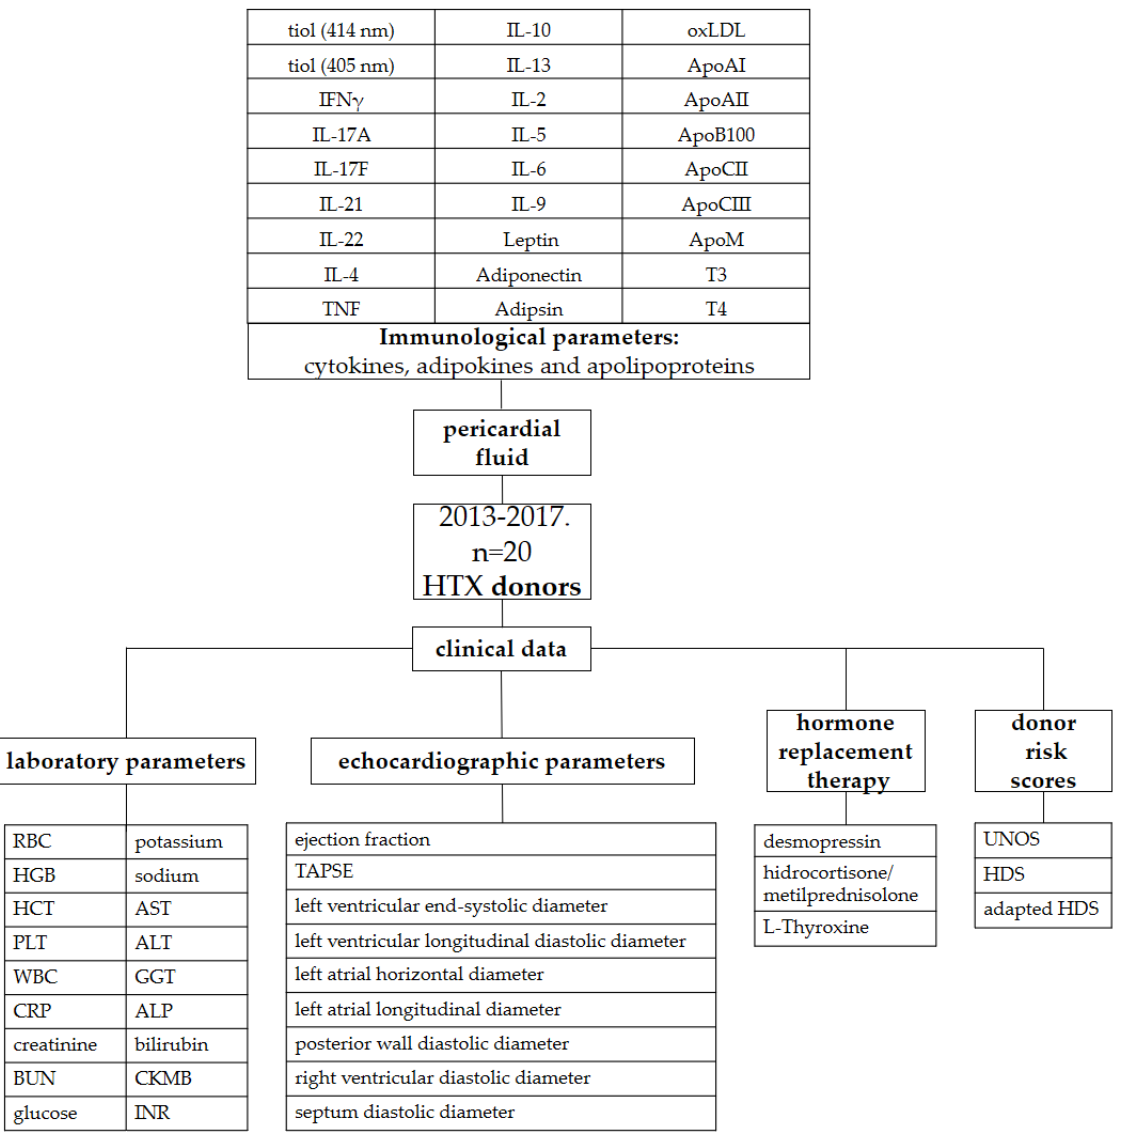
Figure 3. Description of the study. ALP: alkaline phosphatase; ALT: alanine transaminase; Apo: apolipoprotein; AST: aspartate aminotransferase; BUN: blood urea nitrogen; CKMB: creatin kinase-MB isoform; CRP: C-reactive protein; GGT: gamma-glutamyl transferase; HCT: hematocrit; HDS: Heart Donor Score; HGB: hemoglobin; HTX: heart transplantation; IFN γ: interferon-γ; IL: interleukin; INR: international normalised ratio; oxLDL: oxidized low-density lipoprotein; PLT: platelet count; RBC: red blood cell; T3: triiodothyronine; T4: thyroxine; TAPSE: tricuspid annular plane systolic excursion; TNF: tumor necrosis factor; UNOS: United Network for Organ Sharing; WBC: white blood cells.